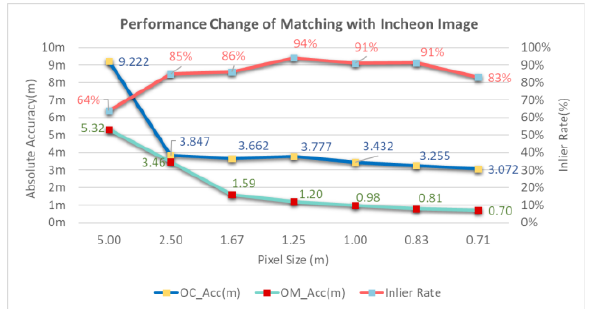
Figure 8. Performance change of matching with Incheon RapidEye